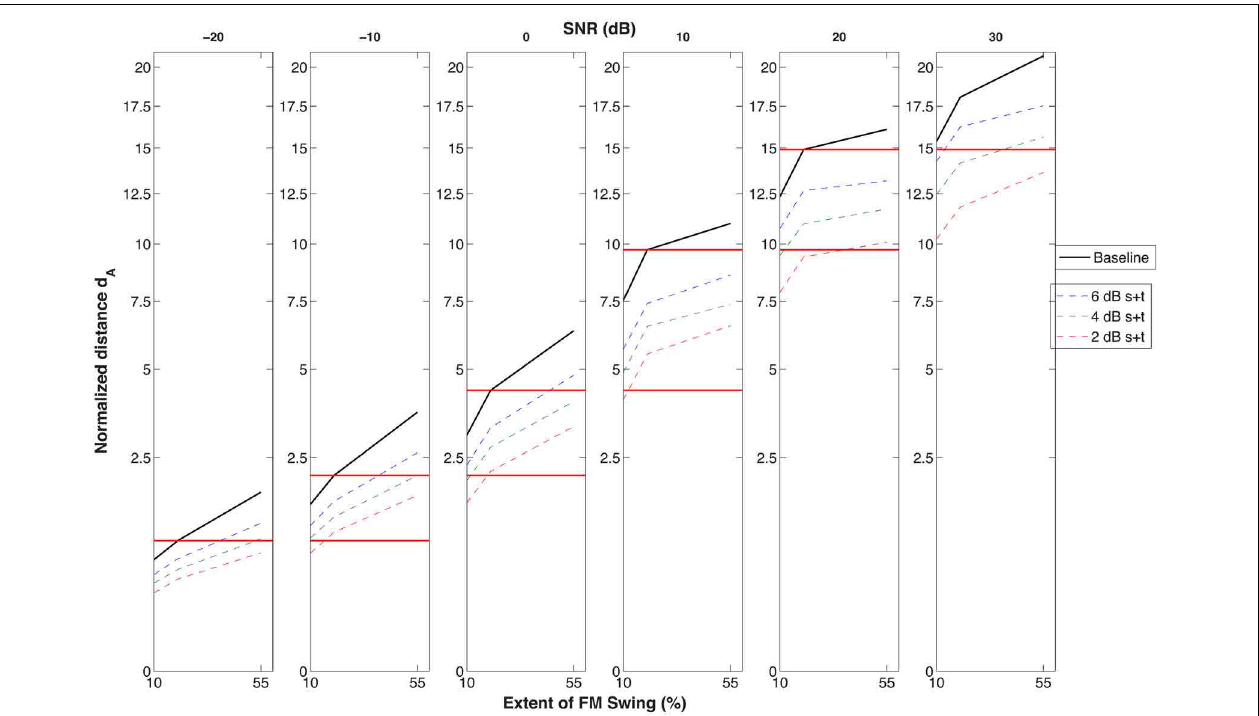
FIGURE 8 | Data simulating the almost-full set of conditions used in the identification experiments: identifiability of the targets (i.e., the cumulative normalized Euclidean distance between the STRF’s evoked by the targets in distracter) as a function of three FM swing extents (10, 20, and 55%) across six SNR’s. The figure wishes to illustrate that, according to this simulation at least, the distance obtained by the un-degraded STRF (simulating the young subject) at he 20% swing extent in the − 20 to + 20dB SNR conditions is approximately